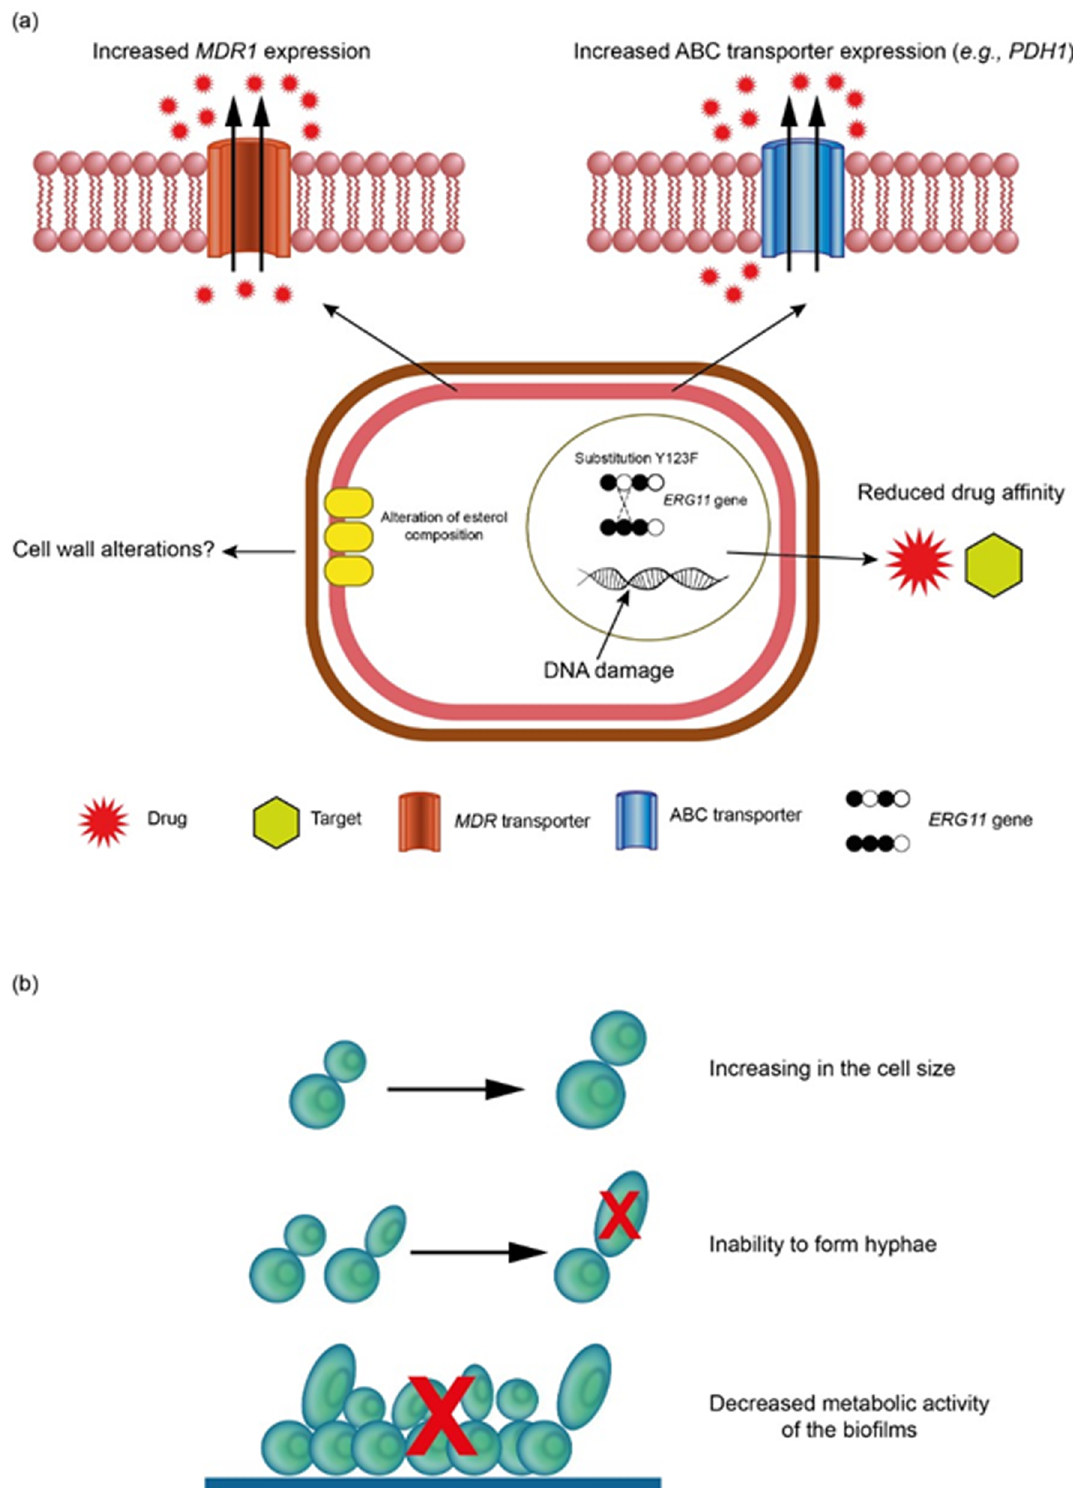
Fig 2. Cellular alterations induced by fungicides exposure in Candida spp. (a) Mechanisms of resistance induced by fungicides in Candida spp. Azole resistance triggered by fungicide exposure shows up-regulation of ABC multidrug transporters, such as PDH1 . In addition, amino acid substitution Y132F in the erg11 gene can occur, suggesting that this selected resistance is mainly associated with